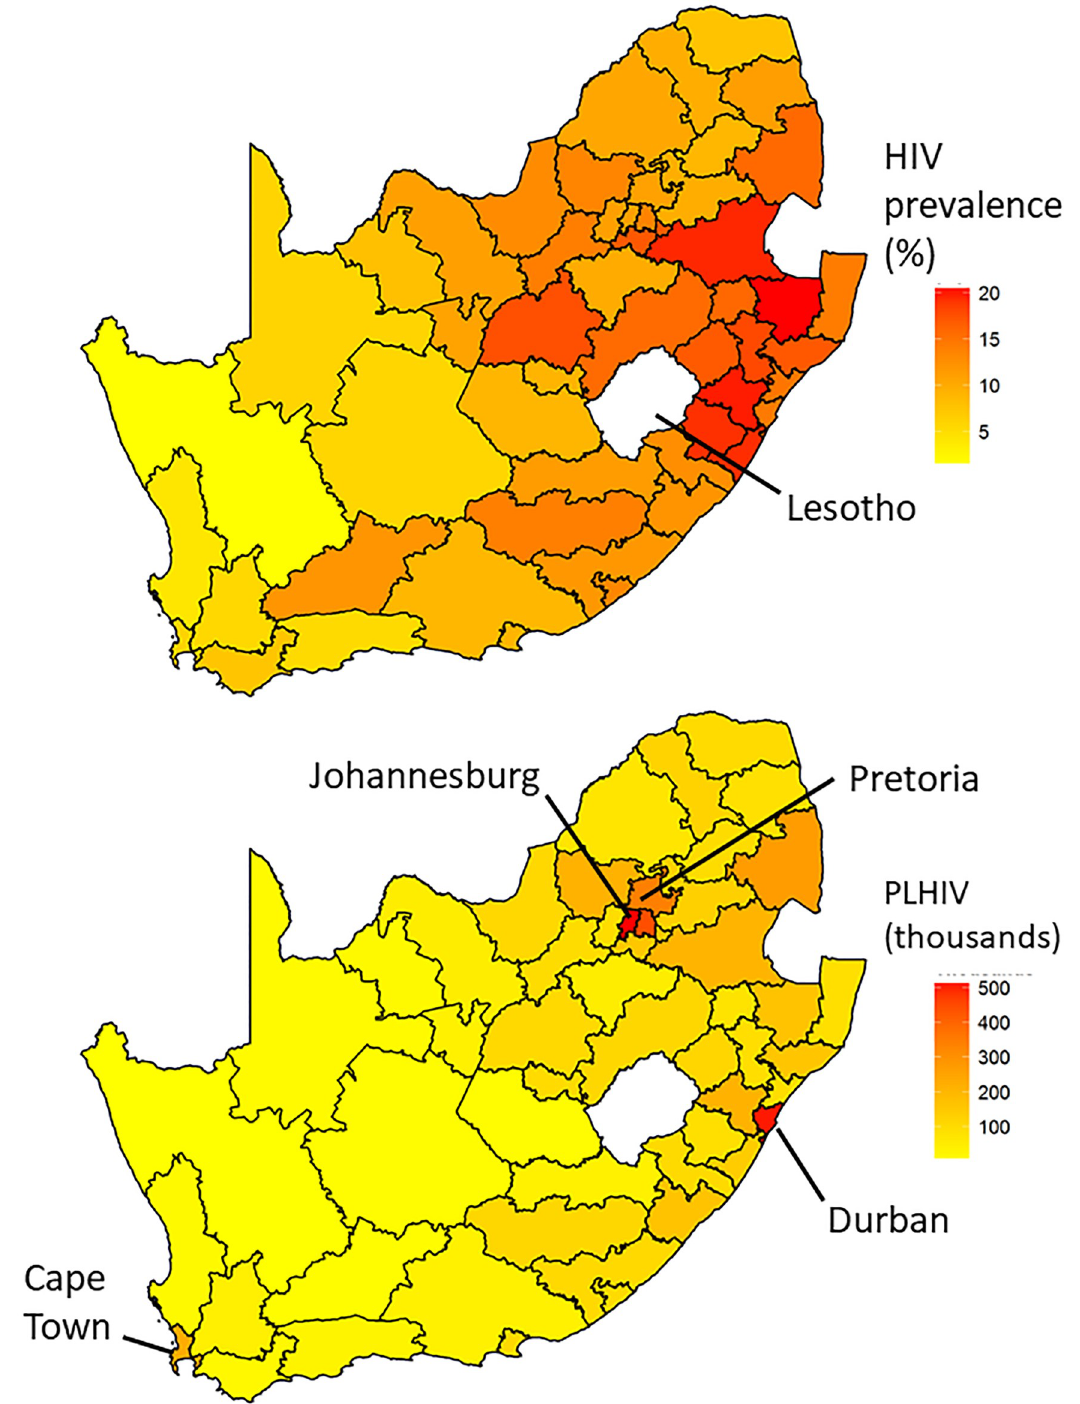
Fig 4. Geographic distribution of HIV prevalence and burden. Geographic distribution of HIV prevalence (top) and numbers of people living with HIV (PLHIV, bottom) in South Africa, 2012, based upon Fay-Herriot small-area estimation. Numeric values of estimates are provided in S2